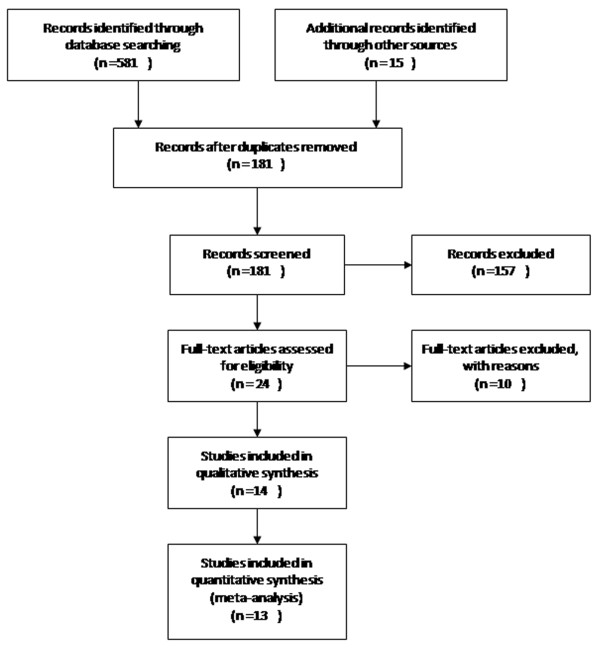
PRISMA 2009 flow chart. Only original experimental articles that were published in English and that analysed the differences in miRNA expression between PDAC tissue and noncancerous pancreatic tissue in humans were included. Articles were excluded if the studies did not use a miRNA microarray platform or if they profiled miRNAs in different histological subtypes.